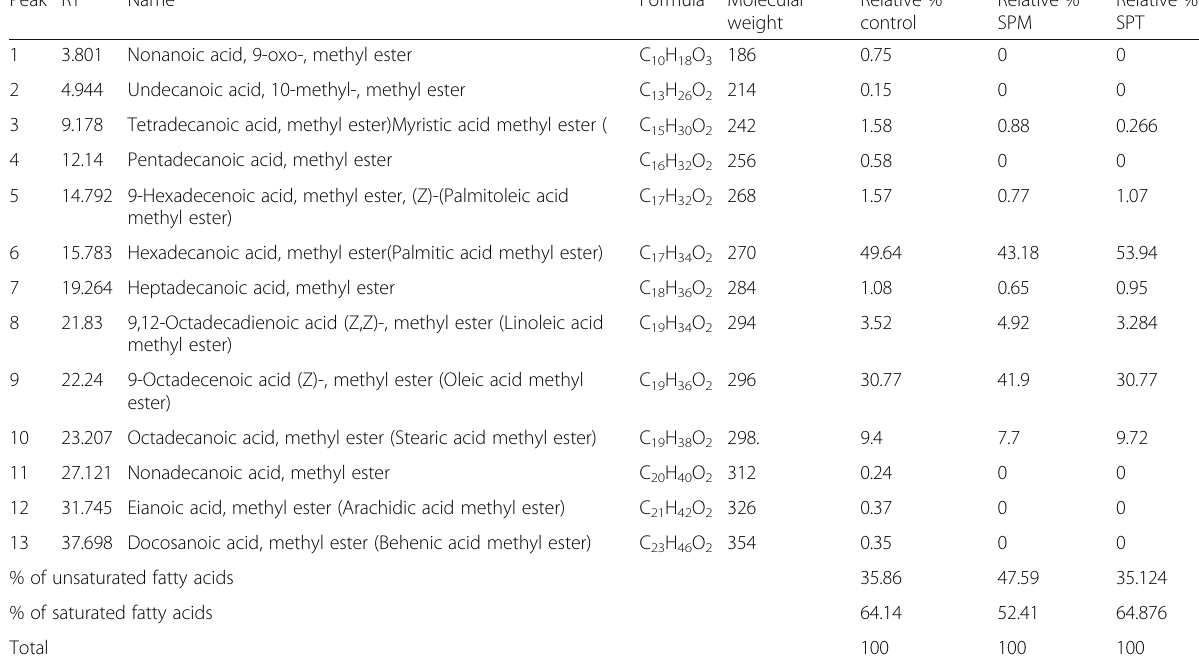
Table 3 Effect of SPM and SPT on the fatty acids composition of S . littoralis larvae Peak